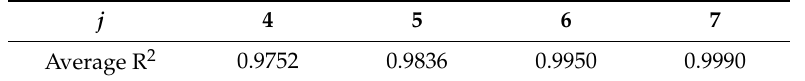
Table 2. Average R 2 of fitting curves with mc % = 1.13% when j equal to various values.